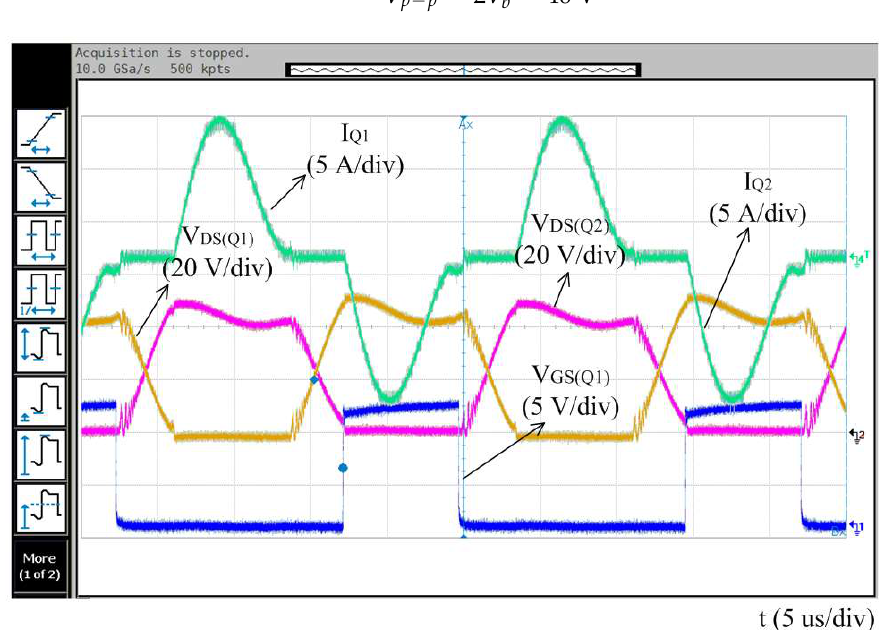
Figure 12. Steady-state waveforms of the converter.